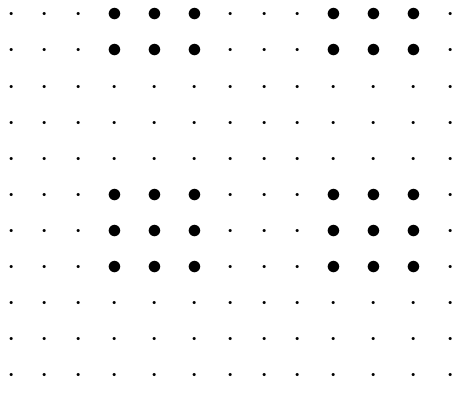
Figure 1: The set B